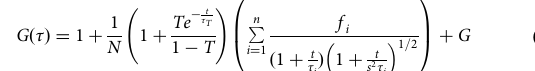
H3S10ph immunostaining and mitotic embryos sorting . A pool of 1h30-2h30 AEL embryos was fi xed as for immunostaining except the fi xation was in 1:1 heptane:1.8% formaldehyde/1X PBS (Thermo Scienti fi c 28906) for exactly 10 min shaking at 450 rpm. Then embryos were rapidly quenched with 125 mM